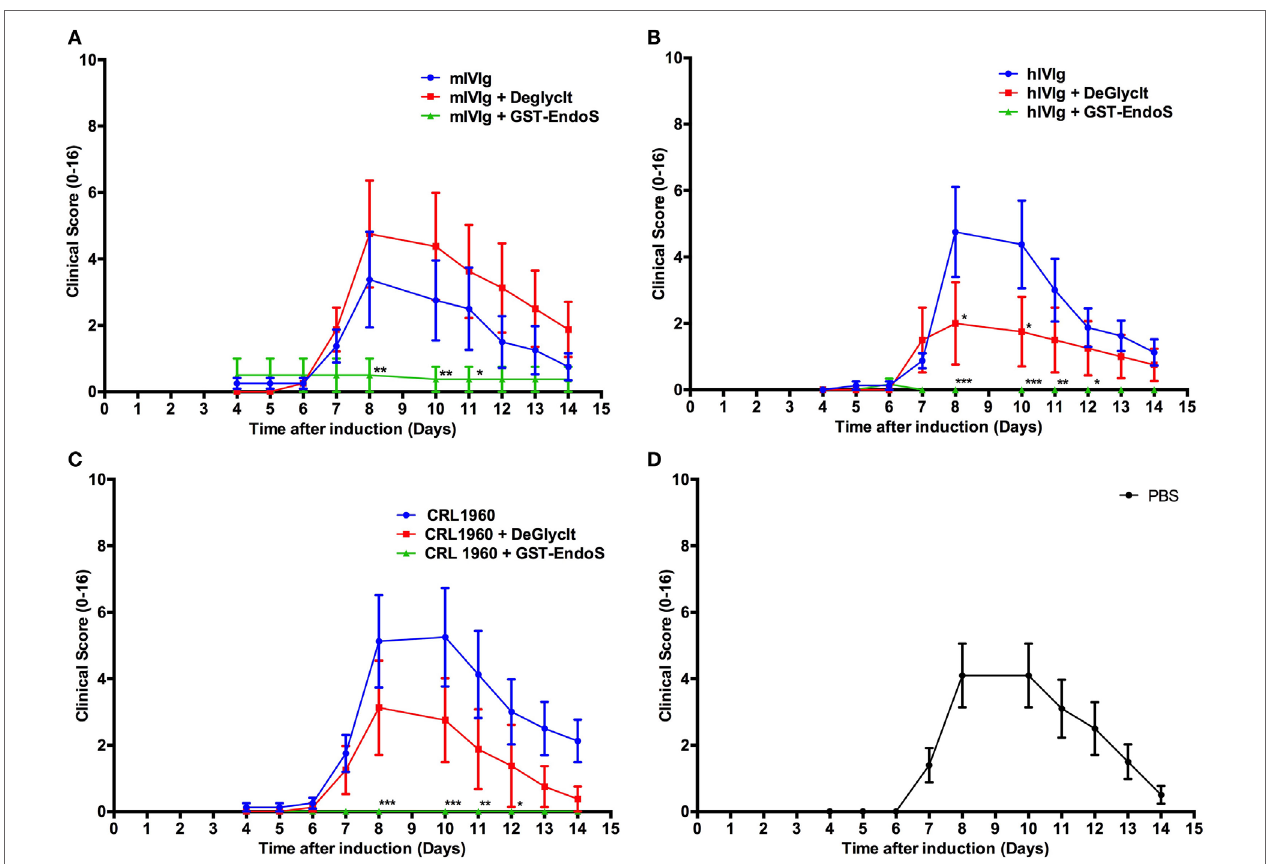
retention times and accurate monoisotopic masses (within < 10 ppm from the theoretical values) of doubly and triply charged ions. Peptide sequences and glycan compositions are indicated. Glycans substituting EDY N STIR and EDY N STLR eluted at approximately 18–20 min and EEQF N STFR at approximately 21–23 min, respectively.